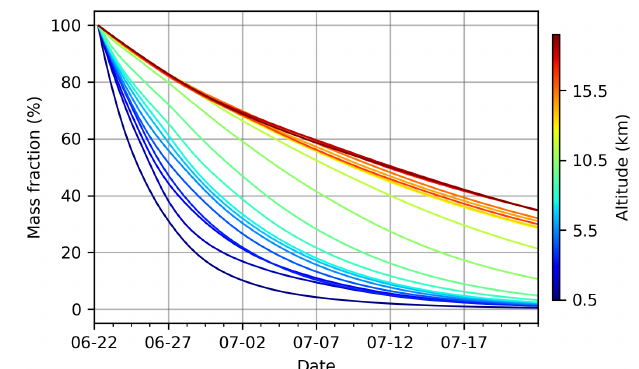
Figure 10. Temporal change of the remaining fraction of SO 2 mass for injections at different 1km thick layers between 0 and 25km and from 21 June 2019, 18:00UTC, to 22 June 2019, 06:00UTC. Colors indicate the altitude at the middle of each 1km thick